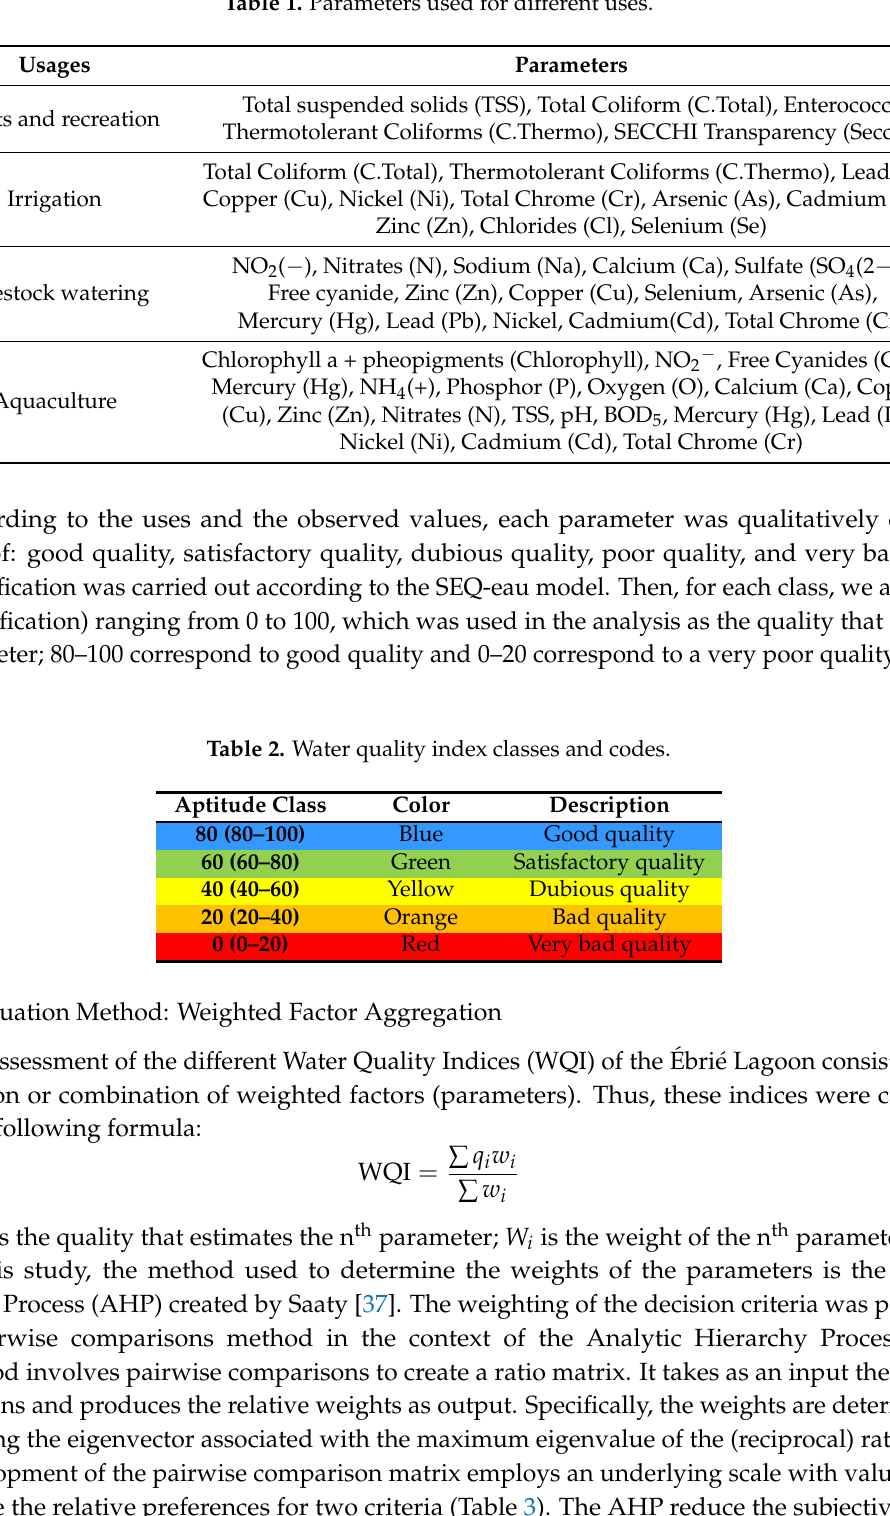
Table 1. Parameters used for different uses.